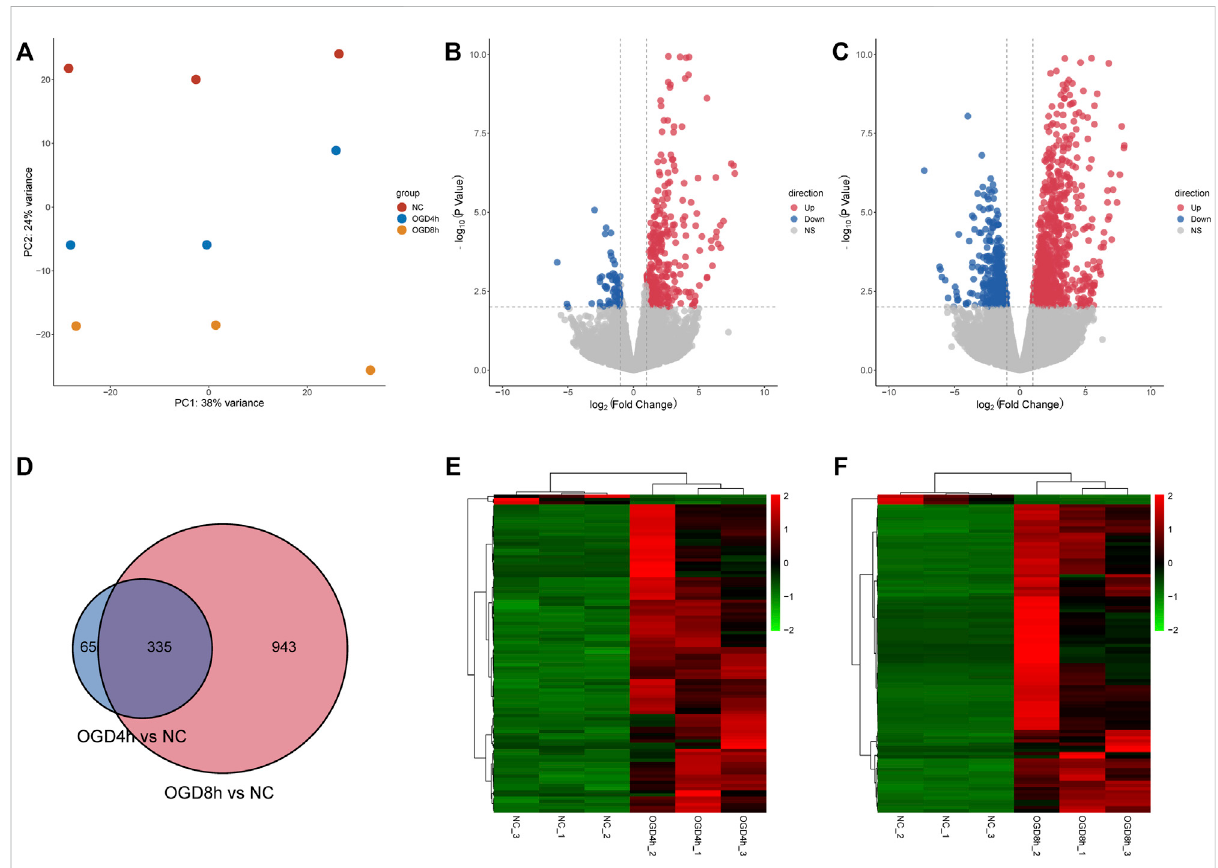
FIGURE 2 (A) Principal component analysis diagram showing that samples of different groups were signi fi cantly different, and samples within the same group were relatively uniform. (B) Volcano plot showing the distribution of log2-fold change and – log10 p value of all quanti fi ed proteins in the 4 h model. Blue circles: p < 0.01, log2-fold change < − 1; red circles: p < 0.01, log2-fold change > 1. (C) Volcano plot showing thedistributionof log2-fold changeand – log10 p valueofallquanti fi edproteinsinthe8 hmodel.Bluecircles: p < 0.01,log2-foldchange < − 1;redcircles: p < 0.01,log2-fold change > 1. (D) The Venn diagram shows DEGs identi fi ed at two time points compared to the normal control group. A total of 335 DEGs overlapped between the 4 h group and the 8 h group. (E) Heatmaps showing gene expression values for the differentially expressed genes (DEGs) at 4 h compared with the normal control group. (F) Heatmaps showing gene expression values for the differentially expressed genes (DEGs) at 8 h compared with the normal control